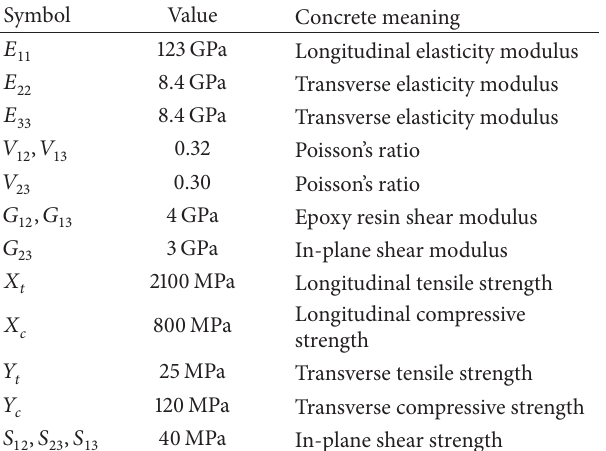
Table 1: T700/epoxy resin composite mechanical properties